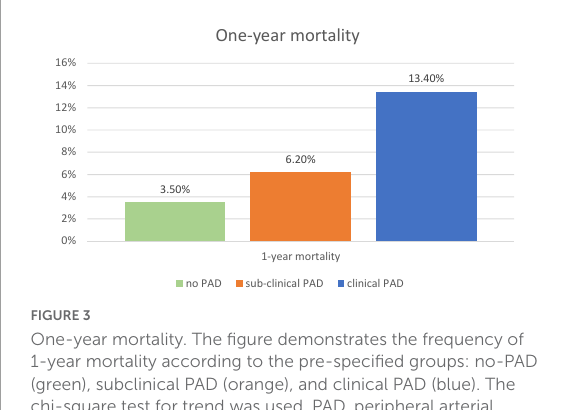
FIGURE3 One-year mortality. The figure demonstrates the frequency of 1-year mortality according to the pre-specified groups: no-PAD (green), subclinical PAD (orange), and clinical PAD (blue). The